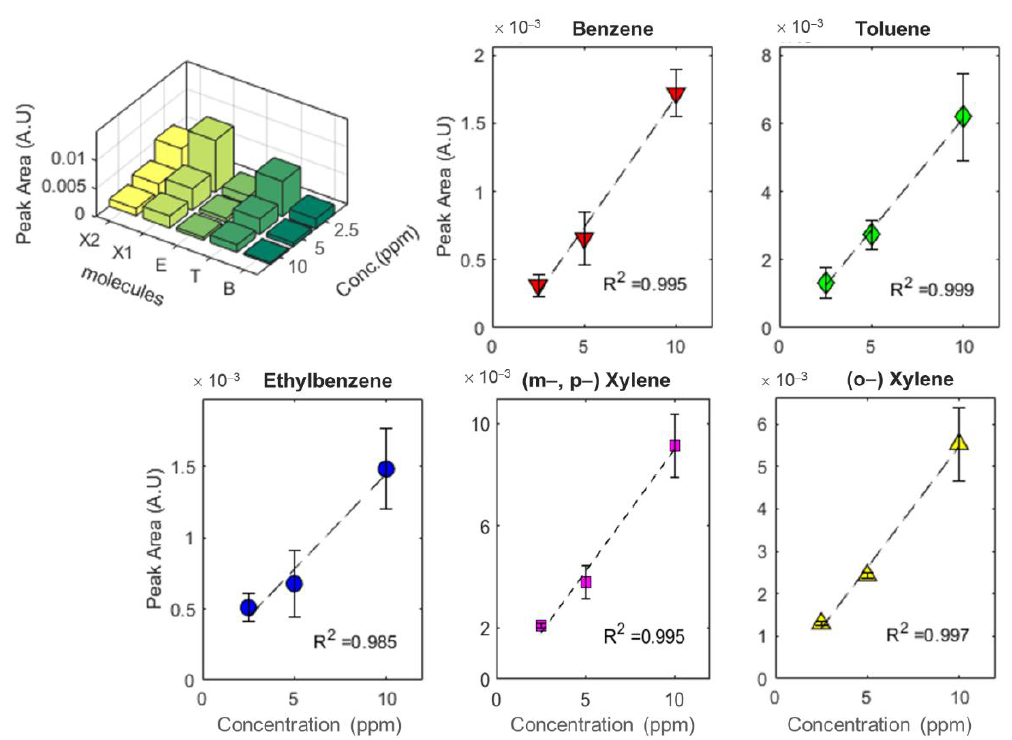
Figure 8. Peak’s area of different concentration (i.e., 10 ppm, 5 ppm, and 2.5 ppm) of BTEX—N 2 at column temperature of 60 °C. B, T, E, X1, and X2 represent benzene, toluene, ethylbenzene, (m-,p-) xylenes, and o-xylene, respectively. The error bar represents the standard deviation of absorbance for three experiments.